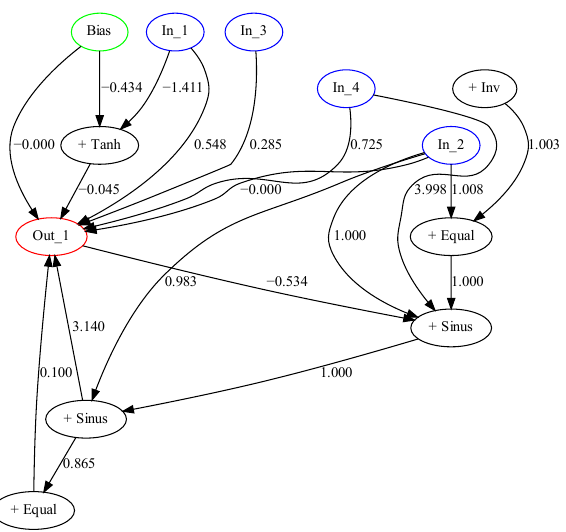
Figure 8. Best controller designed by neuroevolution without